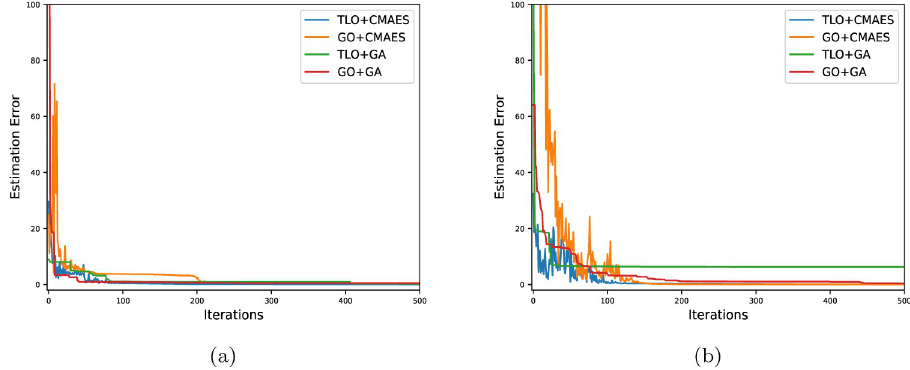
Fig 6. Evolution of estimation errors during model-based optimization with CMAES: (a) Error evolution for film 1, (b) Error evolution for film 2 in Table 5.